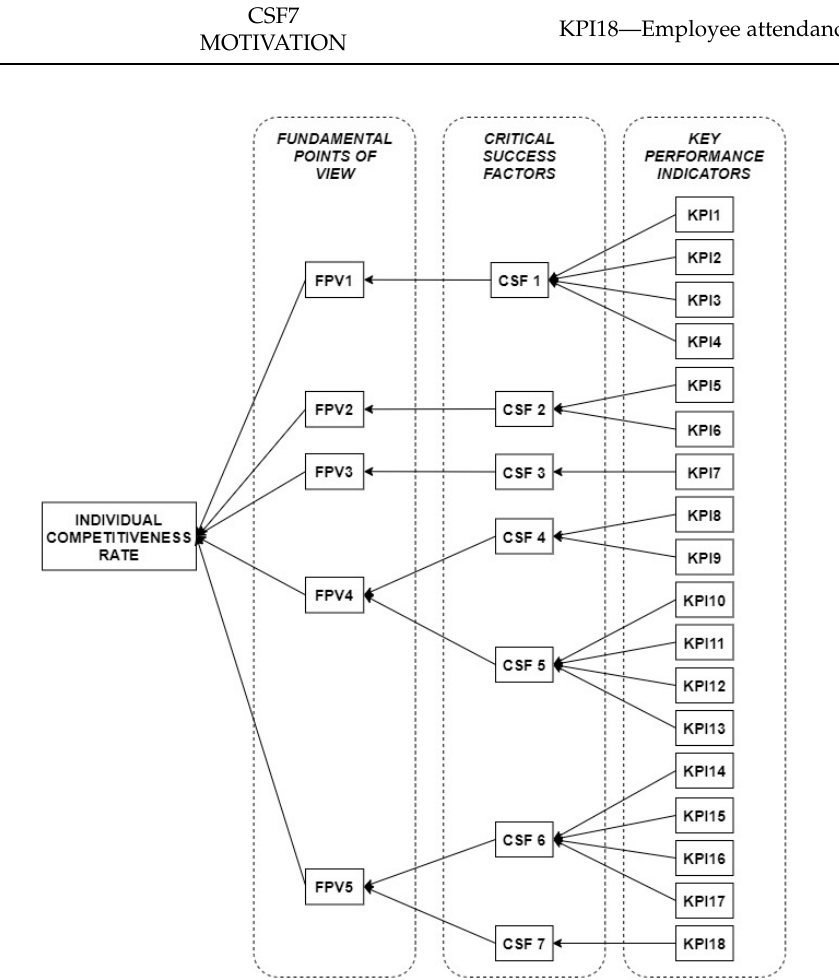
Figure 2. Initial integration of KPIs, CSFs, and FPVs (Schaefer et al. 2020).